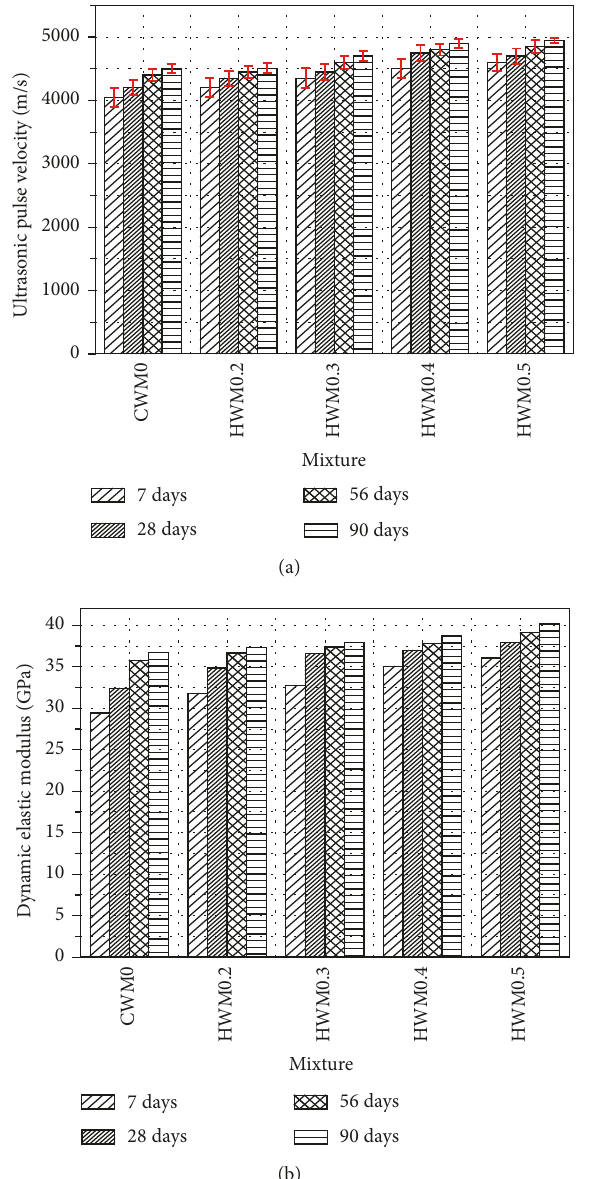
Figure 5: (a) Variation in the UPV values of mortar mixtures with age. (b) Variation in the DEM values of mortar mixtures with age.